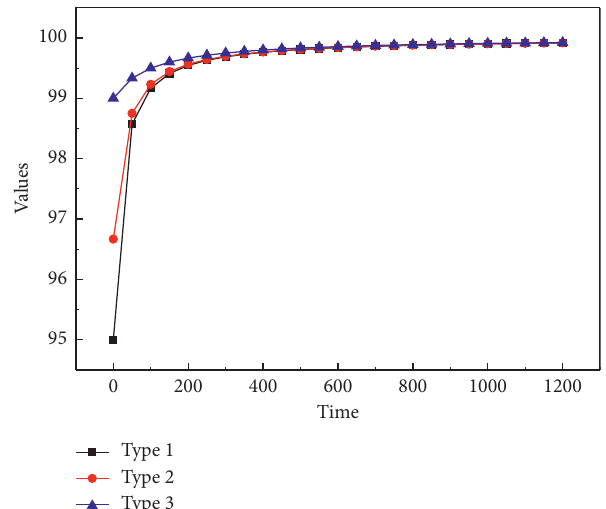
Figure 7: Time series plot of the percentage change of